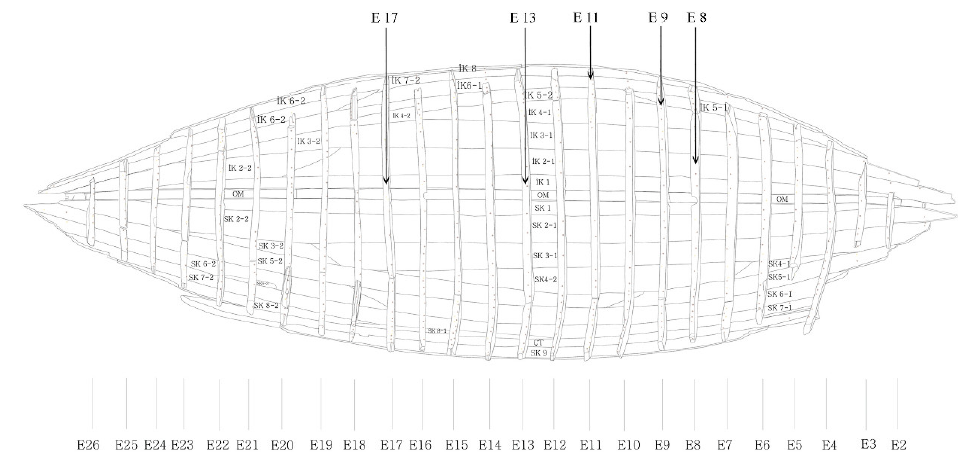
Figure 2. Schematic representation of the YK 12 shipwreck showing the sampling points denoted E8, E9, E11, E13, and E17 (I. Özsait-Kocabaş). Table 1. Wood species of the wood samples taken at the sampling points E8, E9, E11, E13, and E17. Sample Species E8 Hornbeam ( Carpinus ) E9 Oak ( Quercus ) E11 Oak ( Quercus ) E13 Walnut ( Juglans ) E17 Oak ( Quercus